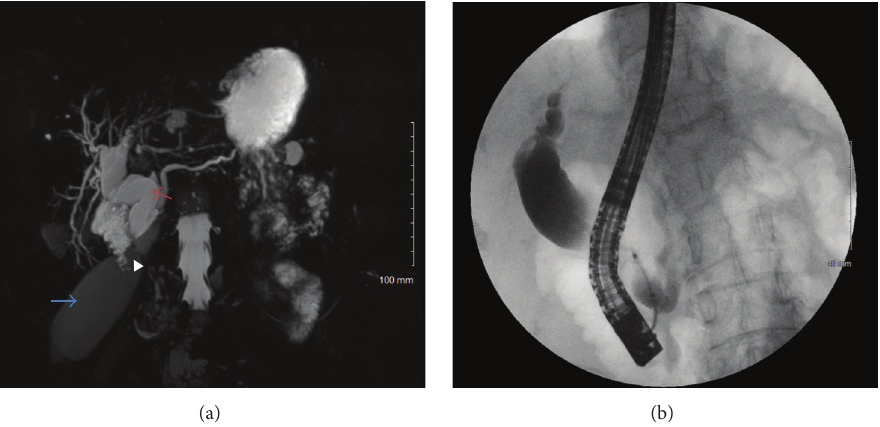
Figure 2: An MRCP image is shown in (a), demonstrating the type 1C choledochal cyst (red arrow), in addition to the distended, torsed gallbladder (blue arrow). Notice the severe narrowing of the gallbladder infundibulum as it joins the dilated bile duct (arrowhead). (b) is an ERCP cholangiogram demonstrating the choledochal cyst without distal common bile duct stricture or stone. The gallbladder did not opacify with contrast due to cystic duct obstruction.